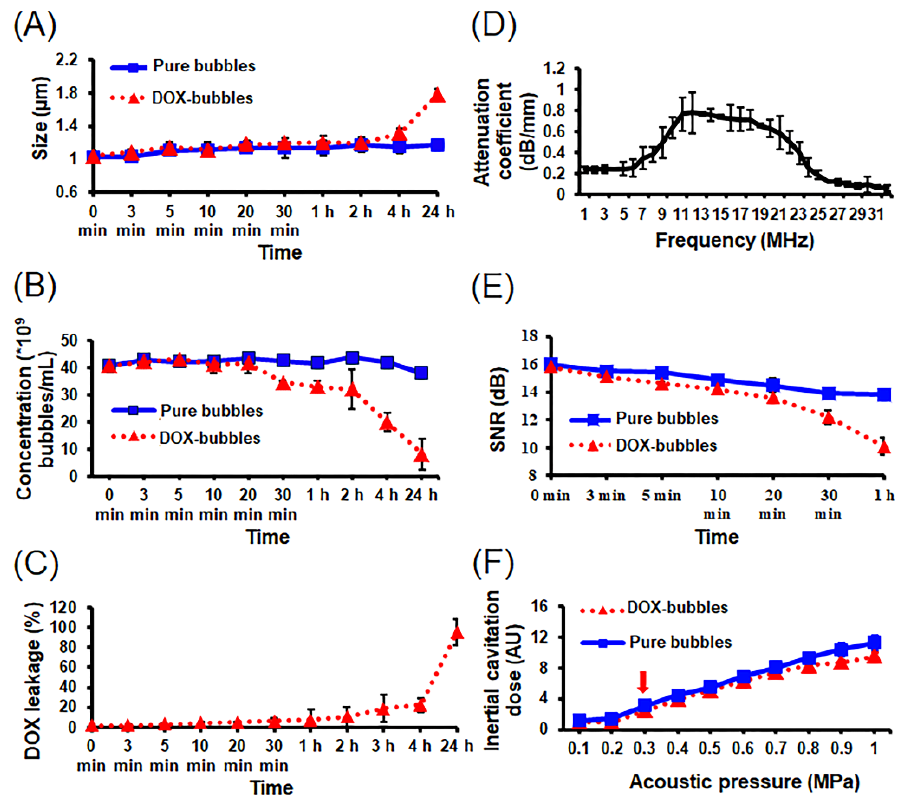
Figure 4. Properties of DOX-bubbles and pure bubbles. Size distribution ( A ) and concentration ( B ) of the two bubbles measured via Coulter counter at 37 °C at different time point. ( C ) Leakage of DOX from DOX-bubbles at 37 °C at different time points. ( D ) Attenuation measurements representing the resonance of DOX-bubbles with respect to the frequency of ultrasonic exposure. ( E ) In vitro acoustic stability of DOX-bubbles and pure bubbles. ( F ) The acoustic destruction threshold of DOX-bubbles and pure bubbles.